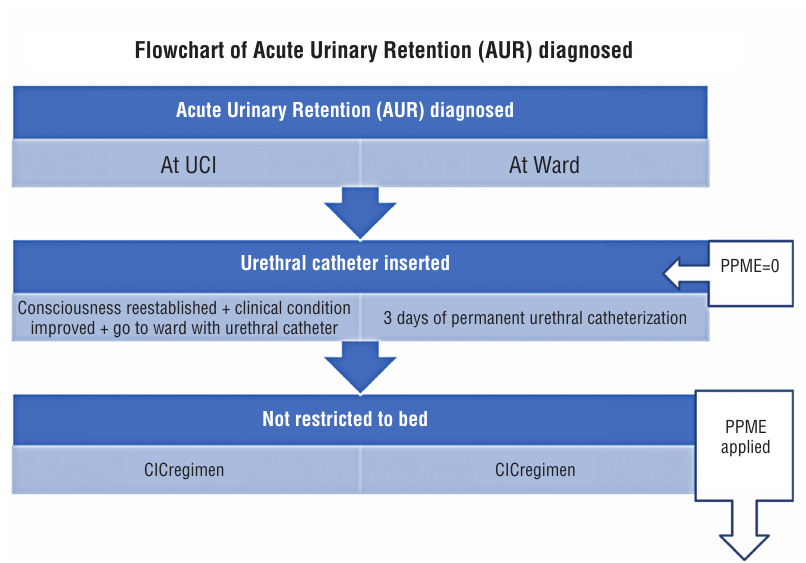
figure 1 - period of hospitalization and discharge rate of 56 patients admitted for acute conditions. flowchart of Acute urinary Retention (AuR)